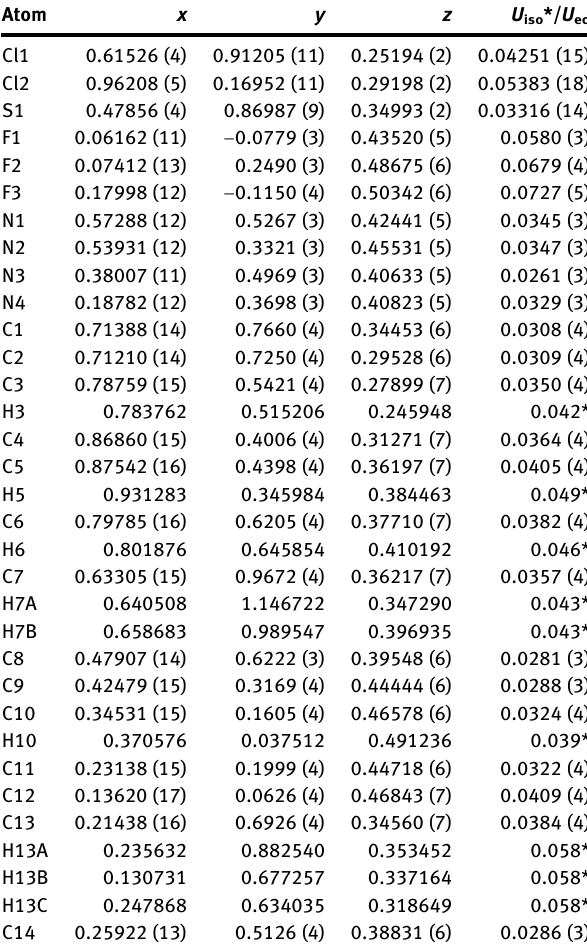
fi gure. The N – N bond distance is 1.384(2) Å. The C – S bond lengths are 1.8266(18) and 1.7468(17) Å respectively. The C – Cl bond lengths are 1.7394(18) and 1.7347(18) Å. In addi- tion, the characteristic C – S – C bond angle is 100.09(8) ° . All geometric parameters are in expected ranges [12].